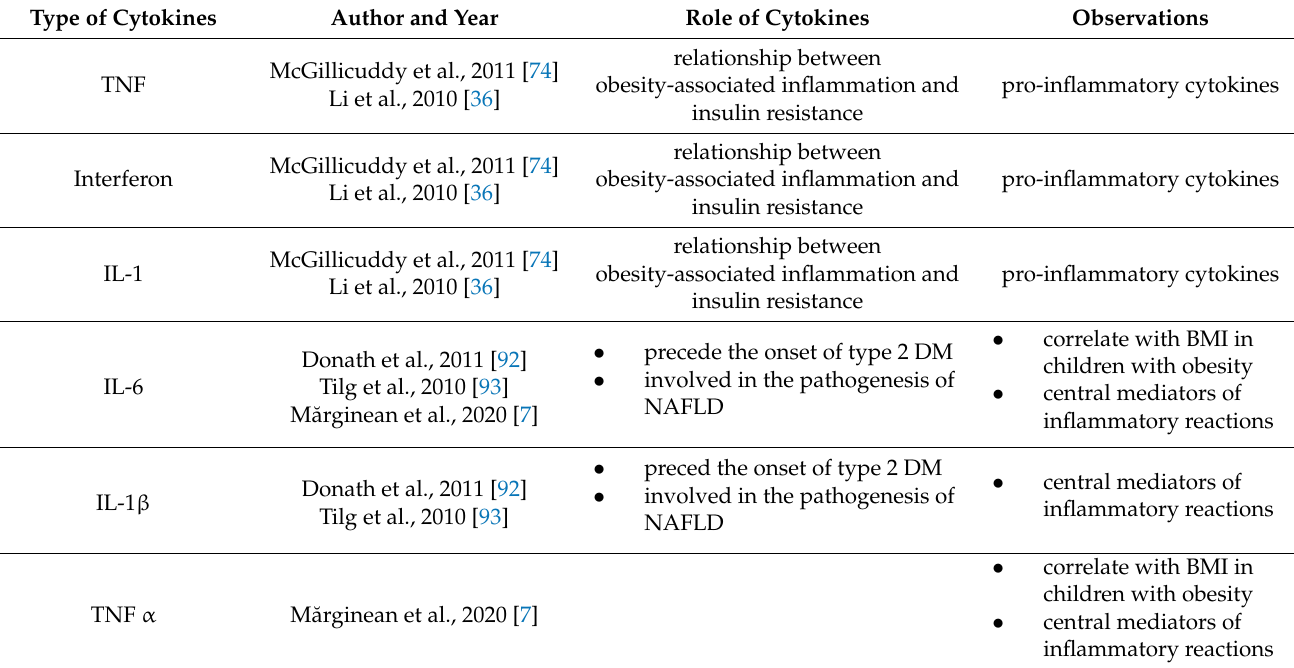
Table 2. The role of cytokines produced by adipose